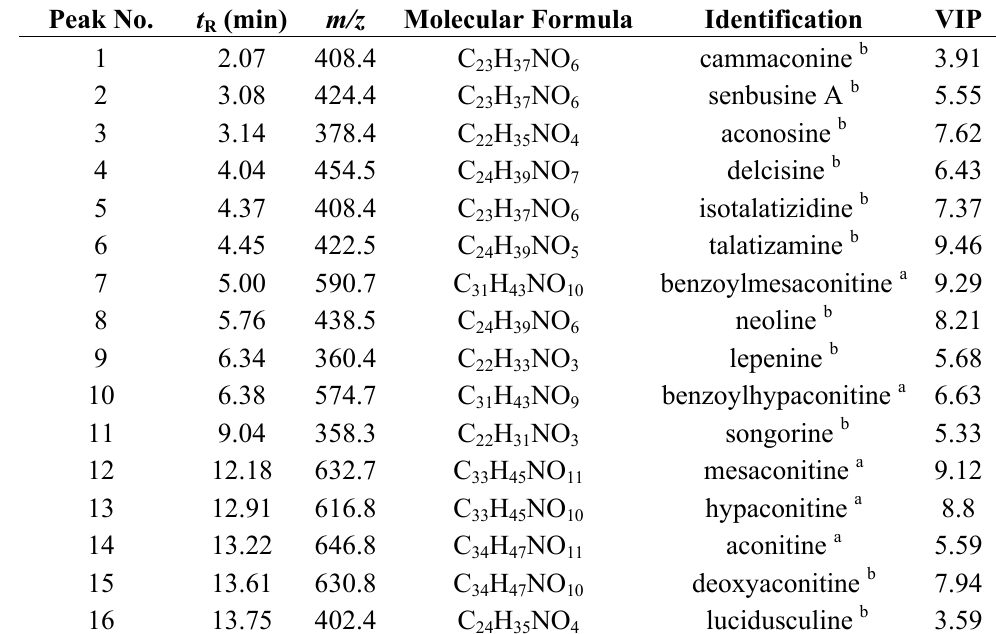
Table 1. Sixteen discriminatory chemical markers of Aconitum herbs and processed products. Peak